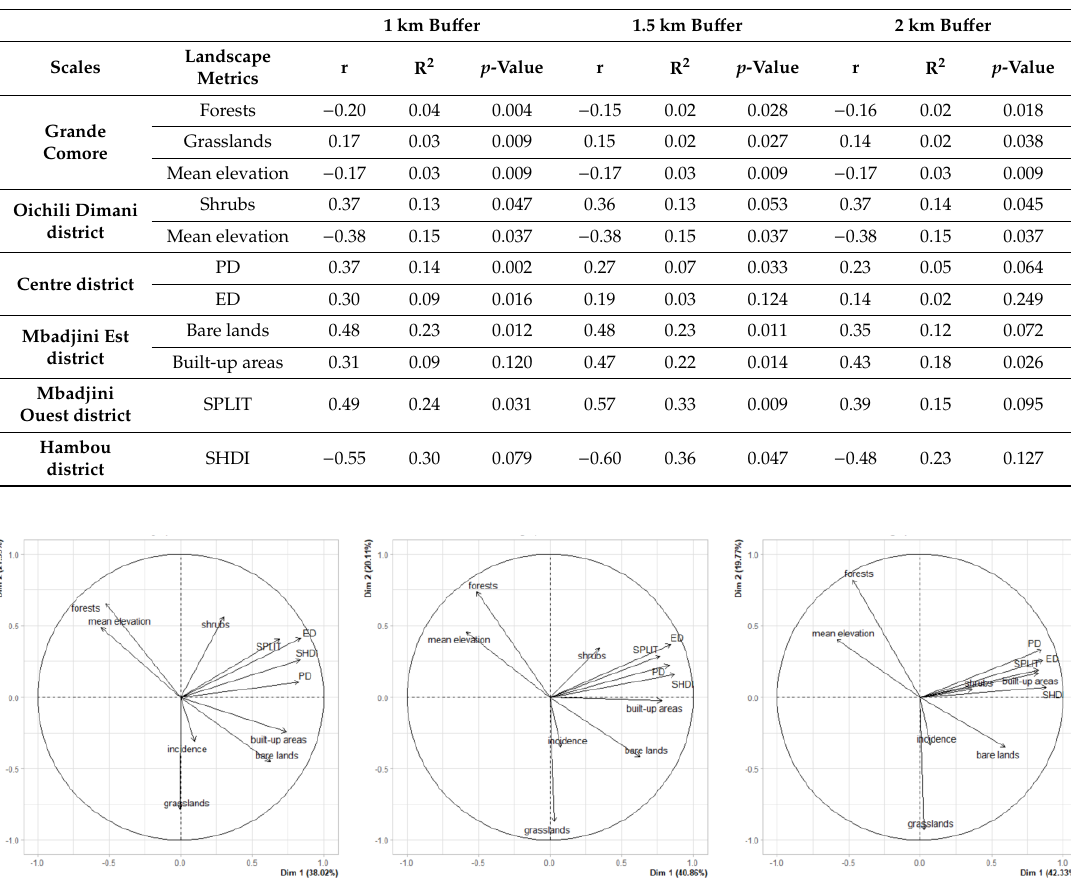
Table 2. Results of linear regression analysis between environmental variables and malaria incidence (in Grande Comore and the 5 districts where significant correlations are observed).